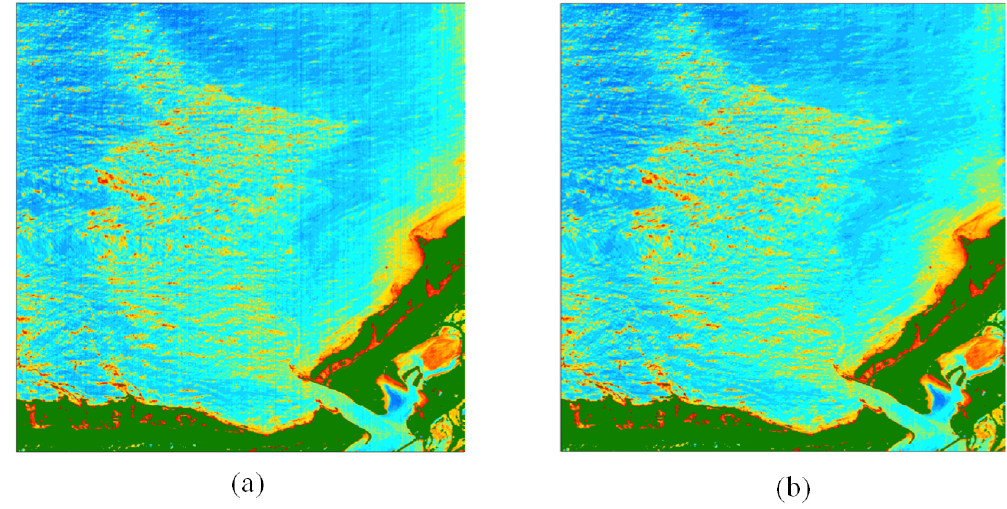
Figure 9. Panel (a) is band 22 ( ∼ 410nm) of a hyperspectral image which was taken from JPL PRISM JPL (2015). The stripe pattern is vertical and the destriped images are shown in image (b) . Green represents the land of the observed region.